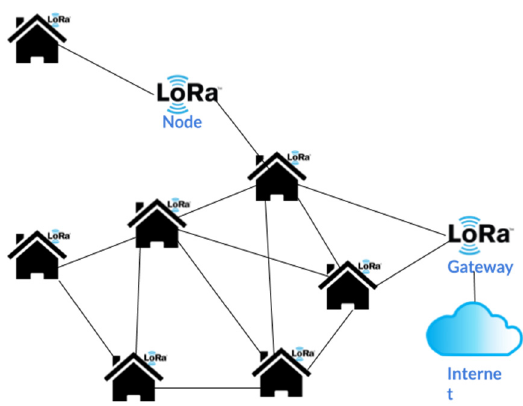
Electronics 2021 , 10 , x FOR PEER REVIEW Figure 7. LoRaWAN mesh architecture. Figure 7. LoRaWAN mesh architecture.